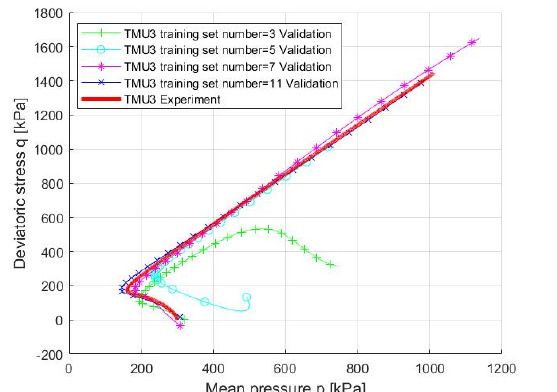
Fig. 5 Deviatoric stress q versus mean pressure p in undrained monotonic triaxial tests ( I D0 = 0.62 and p 0 = 300 kPa).